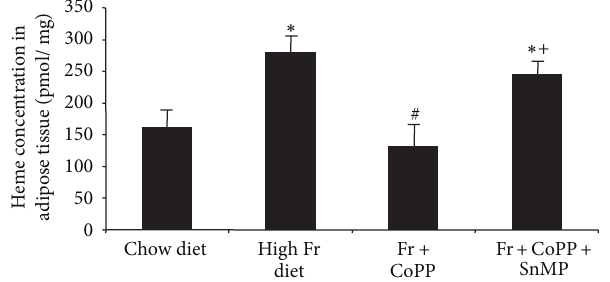
Figure 6: Cellular heme content from adipose tissue in mice fed chow diet, high fructose diet, and high fructose diet treated with CoPP, in the presence or absence of SnMP. Values represent means ± SEM of four independent mice per group. ∗ 𝑃 < 0.05 versus chow diet or # 𝑃 < 0.05 versus high fructose diet or + 𝑃 < 0.05 versus high fructose with